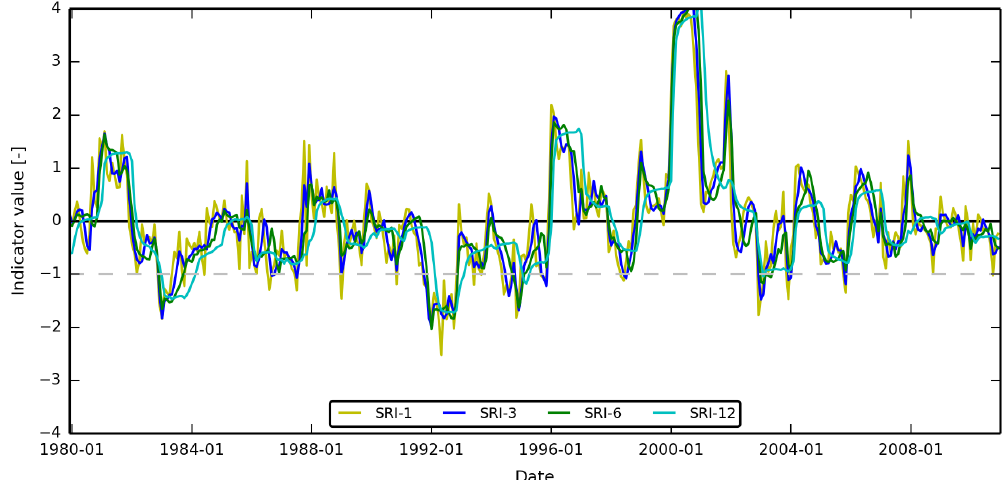
Figure 4. Simulated SRI for station